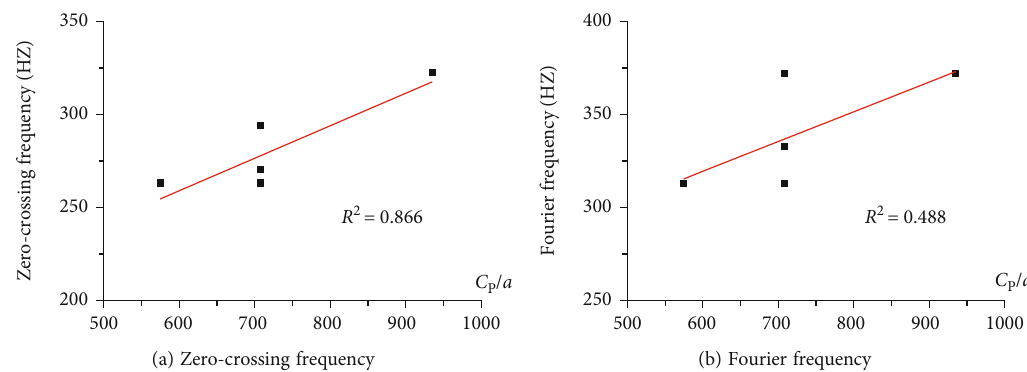
Figure 9: Linear fi tting relationship between the dominant frequency and C